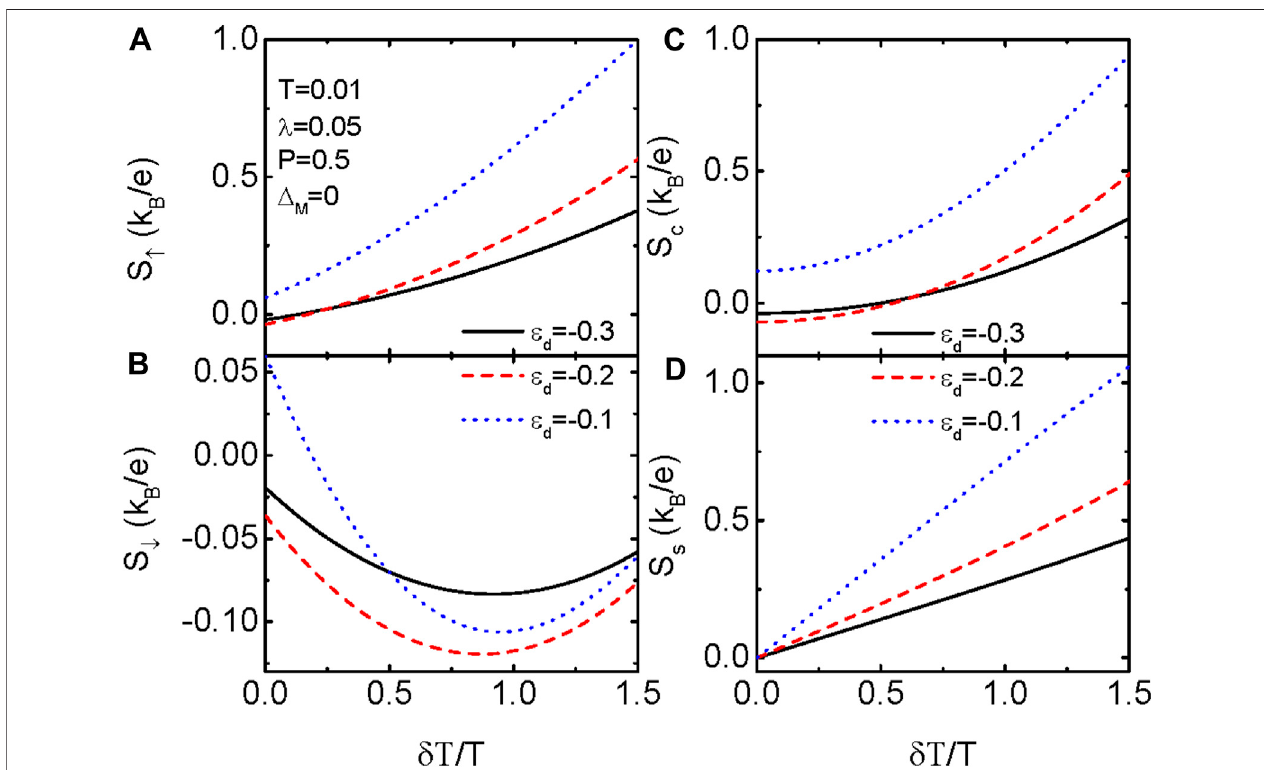
FIGURE 3| Spin-up thermopower in (A) , spin-down thermopower in (B) , charge thermopower in (C) and spin thermopower in (D) as functions of SHA magnitude δ T for indicated parameters.